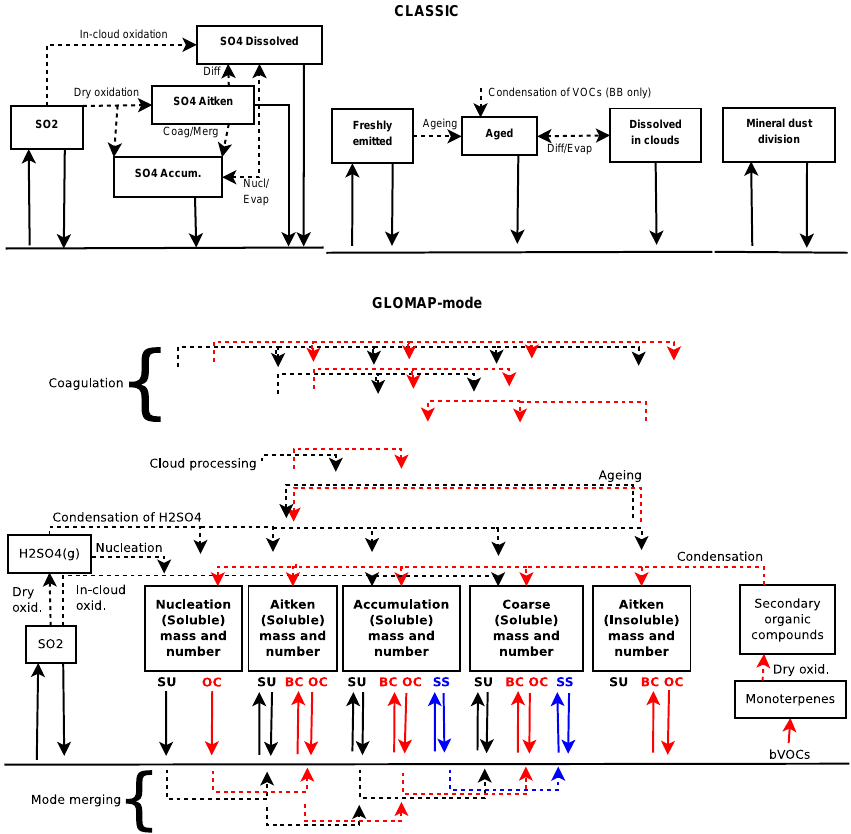
Fig. 1. Summary of CLASSIC (top) and GLOMAP-mode (bottom) aerosol schemes. CLASSIC represents the mass of the external mixture of sulphur cycle (left), carbonaceous (middle), and mineral dust aerosols (right). CLASSIC sea-salt and secondary organic aerosols are purely diagnostic and are not represented on those diagrams. GLOMAP-MODE simulates the mass and number of five aerosol modes where sulphate (SU, black), black and organic carbon (BC and OC, red), and sea-salt (SS, blue) aerosols are internally mixed. Solid arrows represent the total emission and deposition mass fluxes. Dashed arrows represent mass fluxes within each